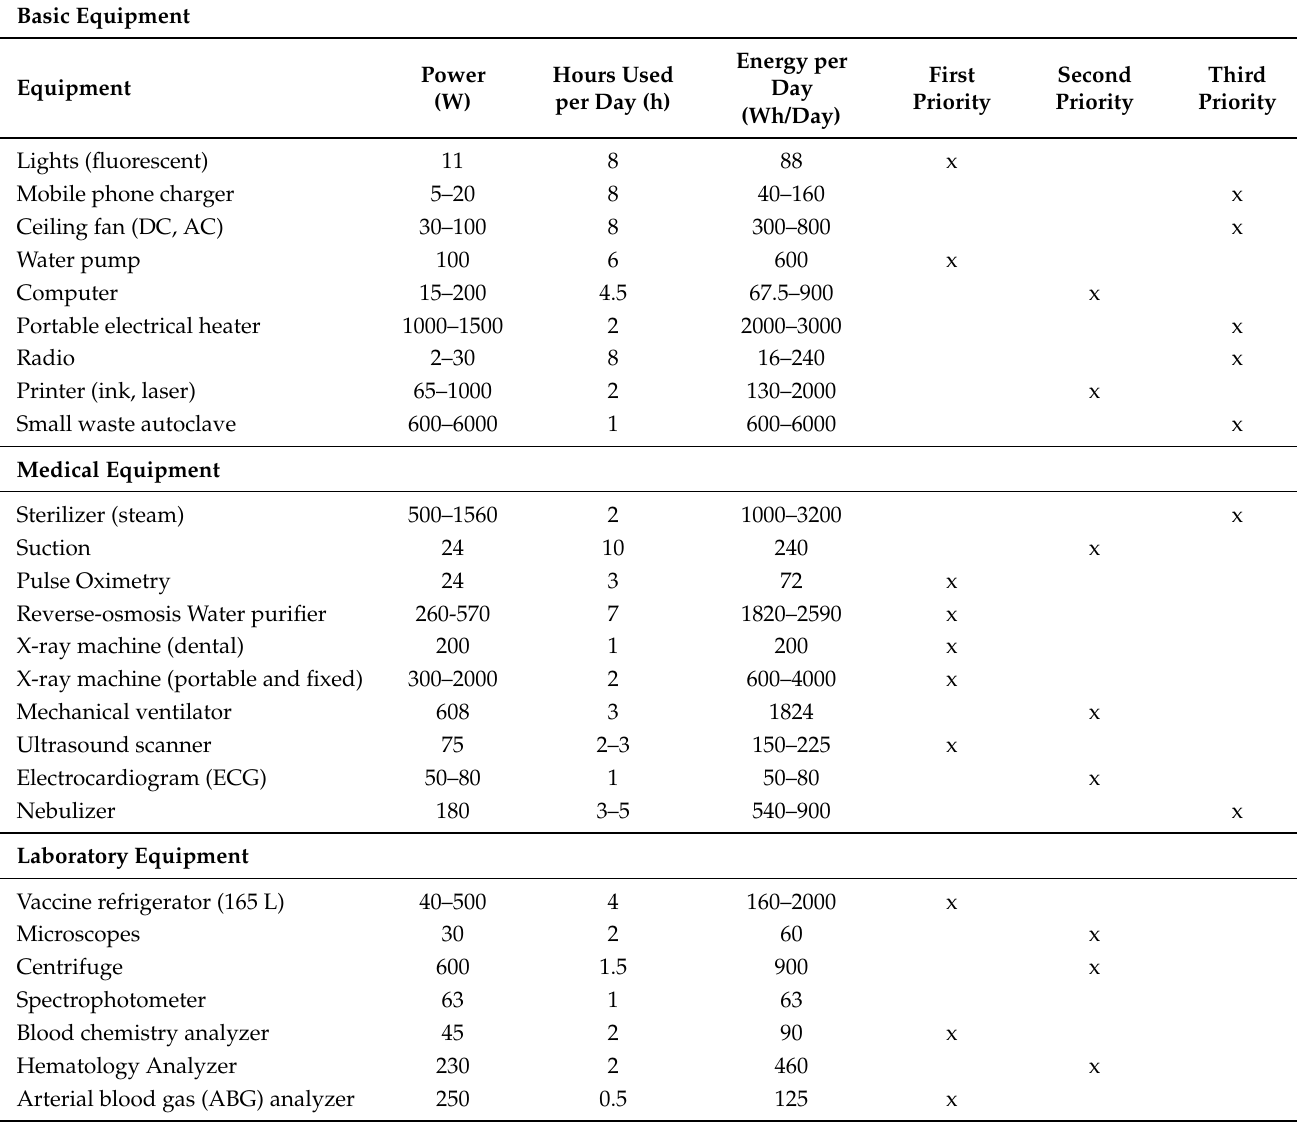
Table 1. Electricity consumption devices in a mobile